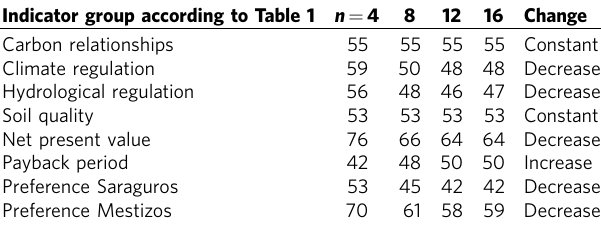
Table 2 | Changes in aggregated indicators when including multiple ecosystem services: Achieved average min–max normalized indicators after optimization with increasing numbers of